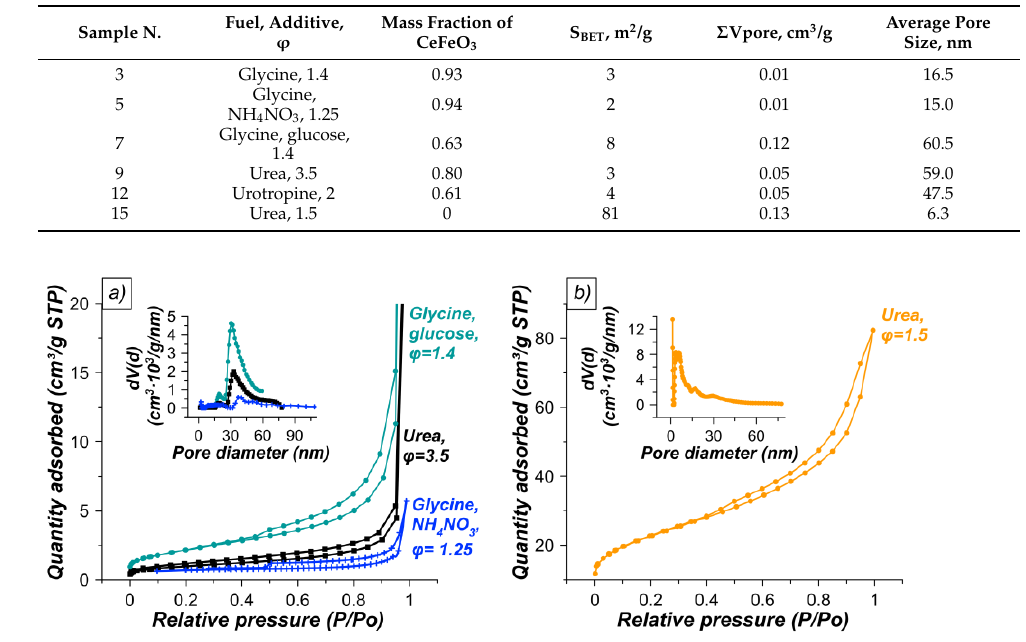
Figure 6. N 2 adsorption-desorption isotherms and pore size distribution for ( a ) the as-prepared CeFeO 3 –CeO 2 –Fe 2 O 3 and ( b ) CeO 2 –Fe 2 O 3 systems produced by SCS using different fuels, additives, and fuel-to-oxidizer ratios ( ϕ